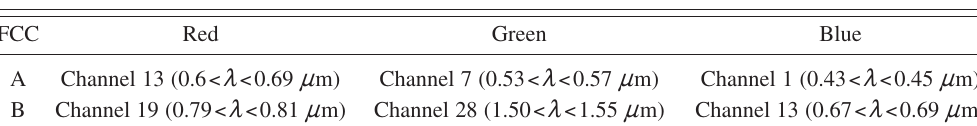
Table II. FCC of MIVIS